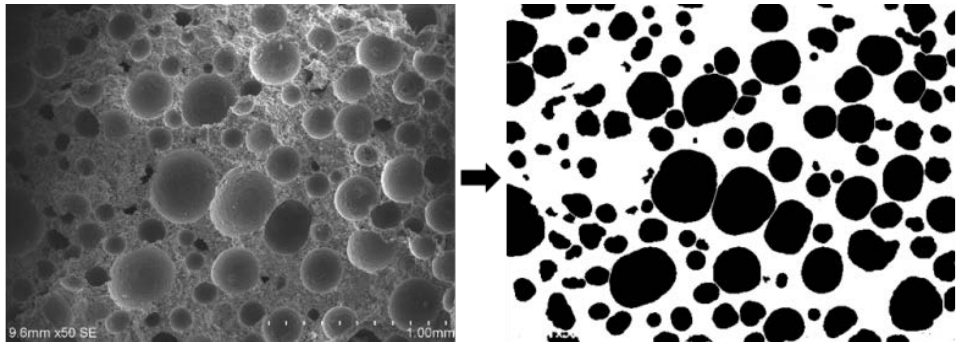
Figure 3. Binary processing of FMLSB pores.